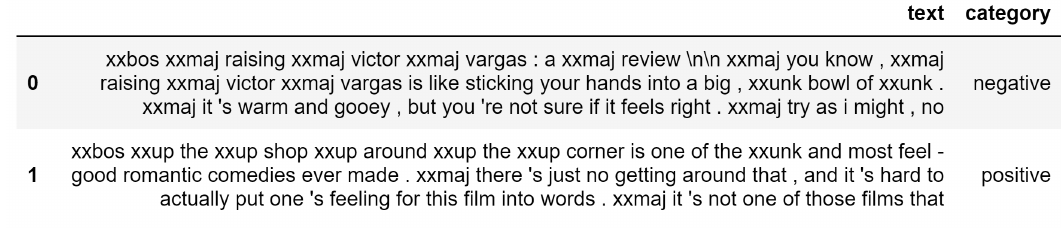
Figure 6. In text classification, the batches are shown in a DataFrame with the tokenized